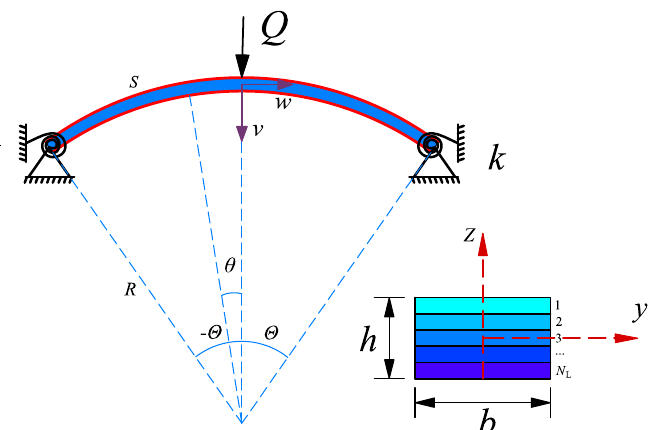
Figure 1. Configuration and coordinate system of an elastically supported functionally graded graphene platelet reinforced composite (FG-GPLRC) arch.